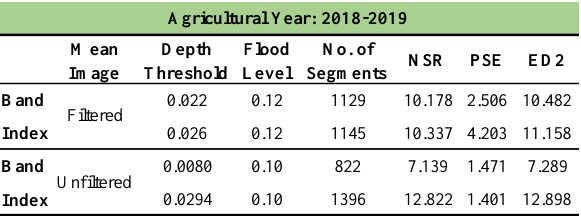
Table 1 . Modified ED2 and parameters tested in mean images of spectral bands and vegetation indices for the 2018-2019 agricultural year.